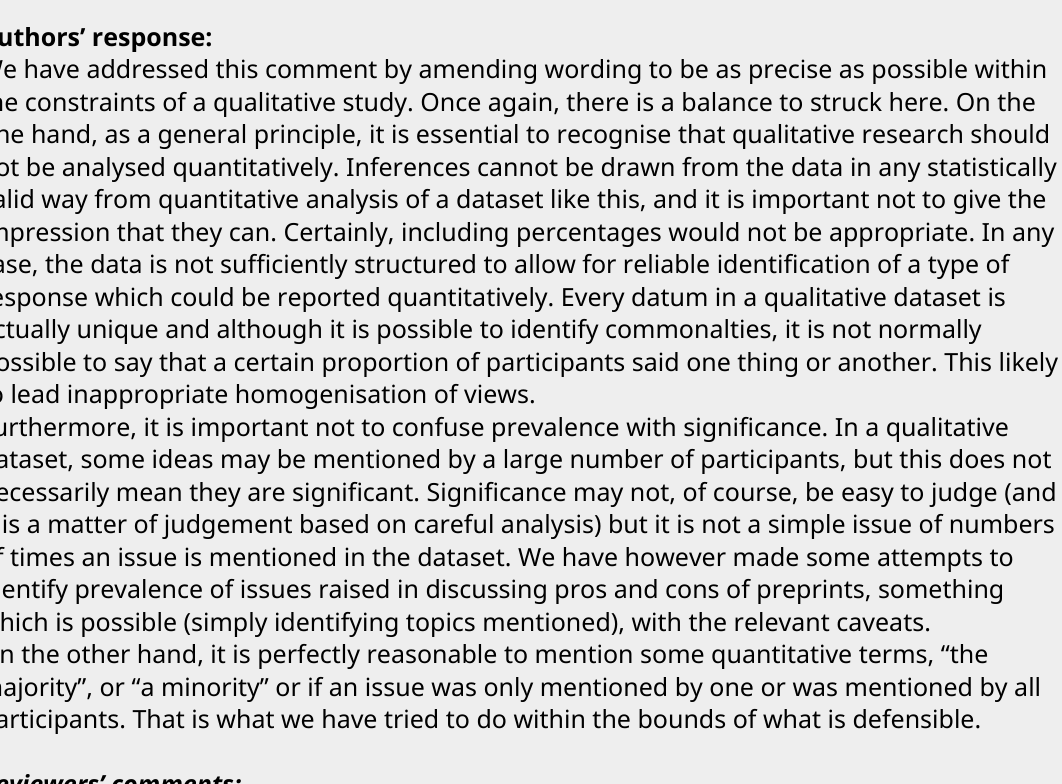
Table 5: Please consider complementing the legend to provide definitions to “systemic” and “individual”.